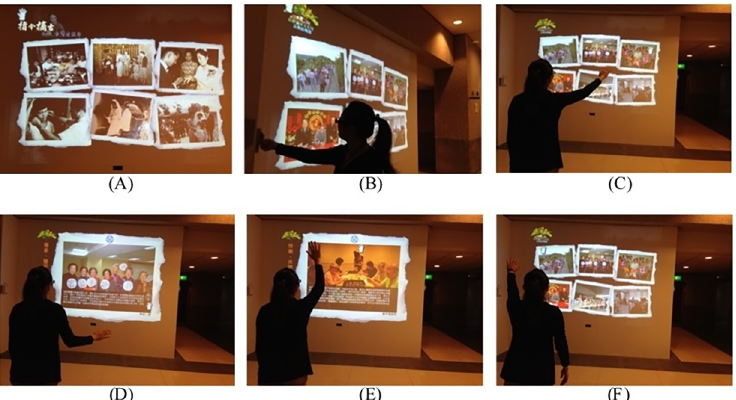
Fig 1. Interactive Wall with Life Memories. (A) Pictures of life memories are projected onto the wall when user stands in the interaction zone and waves their arms to initiate interaction. (B) Users employ personal RFID cards to identify themselves, and are then presented with a series of self-related photographs in the Silver Village, together with collections of pictures from former times and other educational materials. (C–F) Users employ arm gestures to navigate through various categories of photographs and, for each one, are provided with an audio commentary to facilitate the processes of reminiscence and learning.